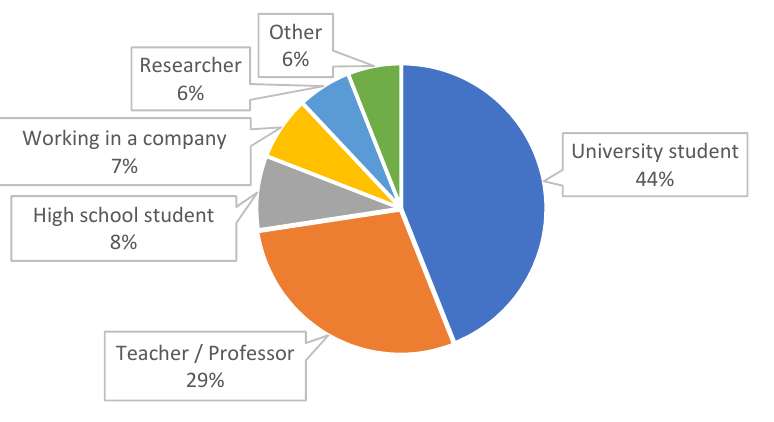
Figure 22. GIM users’ profile.